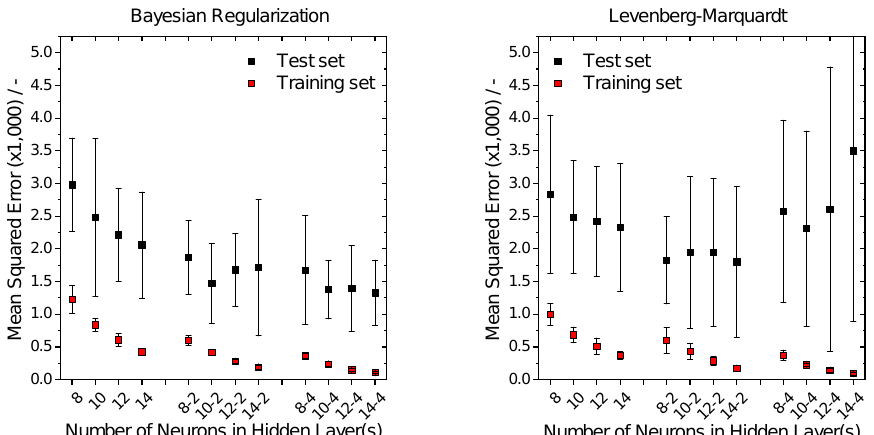
Figure 4. Performance of di ff erent neural network topologies on test and training set trained via Bayesian regularization or the Levenberg–Marquardt algorithm. Markers indicate average mean squared error on normalized output data, and the respective whiskers represent the standard deviation. Each combination of neural network and training algorithm was trained and evaluated 20 times under usage of a new random division of the data into a test and training set for each